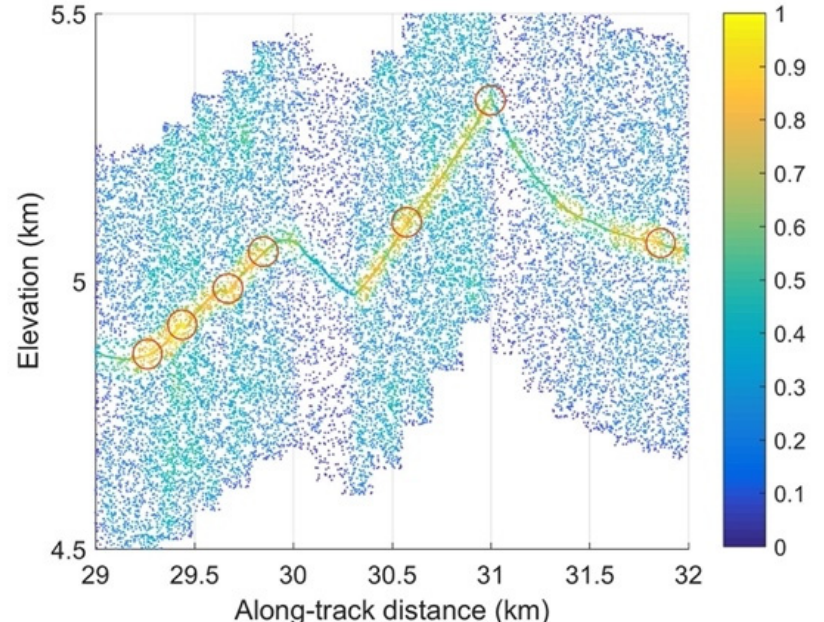
Figure 12. Normalized spatial density of the using data in Figure 10a. The spatial density of each PE is calculated by the number of PEs within a circular neighborhood of a 10-m radius. The maximum spatial density in the whole along-track segment was set as 1. Several sub-segments marked with red circles demonstrate that the direction of the maximum spatial density was not consistent with the direction of the terrain profile due to the very low SNR.